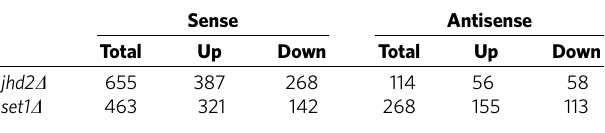
Table 1 | Metrics for sense and antisense transcripts with Z 1.5-fold increase (up) or decrease (down) in expression (FDR r 5%) in jhd2 D or set1 D relative to WT. Sense